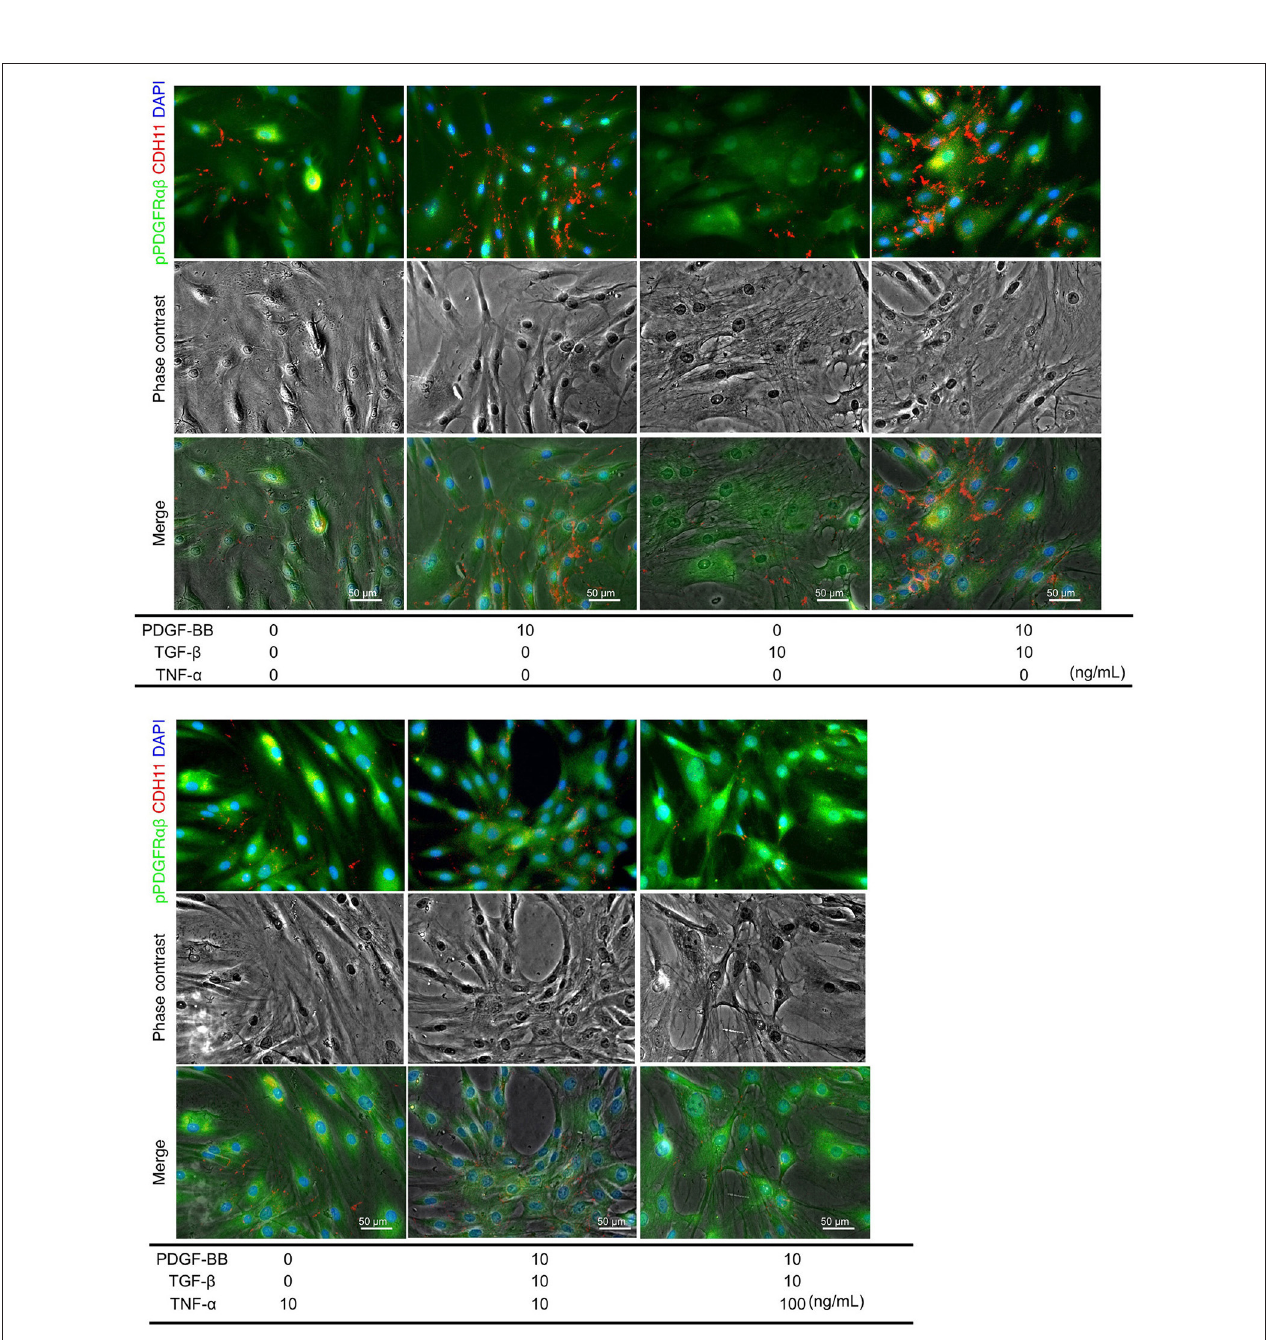
FIGURE 4 | pPDGFR αβ and CDH11 expression by PDGF-BB, TGF- β , and TNF- α stimulation of RA-FLS. The effects of PDGF-BB, TGF- β stimulation alone, PDGF-BB and TGF- β (2GF) stimulation, 2GF + 10ng/mL TNF, and 2GF + 100ng/mL TNF stimulation on RA-FLSs were investigated. Representative images of immunostaining for pPDGFR αβ (green) and CDH11 (red) expression with FLSs stimulated with PDGF, TGF- β , and TNF in each combination.